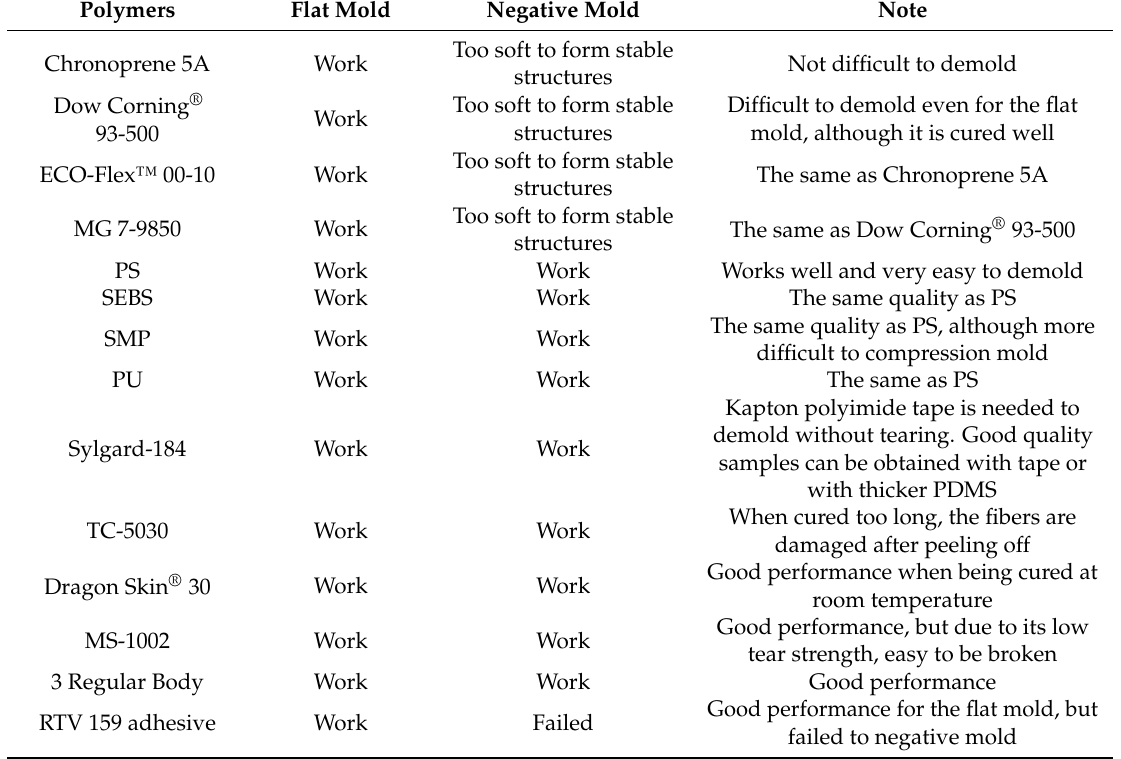
Table 4. Results of peeling polymers from fluorosilicone molds after being